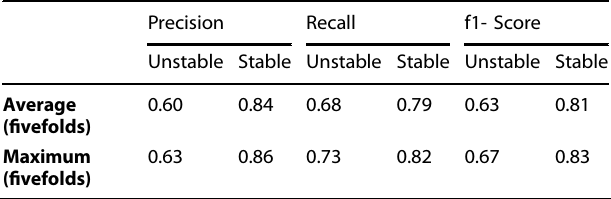
Table 2. The average and maximum classi fi cation metrics that were obtained using a random forest classi fi er across fi vefolds, with a dataset that has been augmented using synthetic